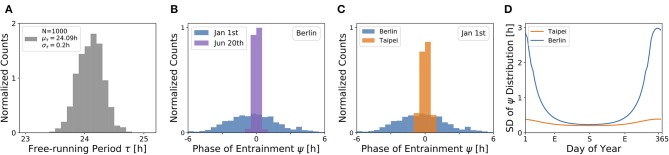
The distribution of chronotypes broadens in winter and at higher latitudes. (A) Distribution of free-running periods τ sampled from a normal distribution of mean μτ = 24.09 h and standard deviation στ = 0.2 h, following what has been described for female human using a forced desynchronization protocol (Duffy et al., 2011). (B) Distribution of entrainment phases ψ (i.e., of chronotypes), that follows from a period distribution as depicted in (A) under natural light entrainment in winter (Jan 1st) and summer (Jun 20th) at the latitude of Berlin (ψ = 52.51°). Approximately 12% of the (most extreme) sampled periods τ do not properly entrain under the conditions on Jan 1st. (C) Distribution of entrainment phases ψ during winter (Jan 1st) in Berlin (blue) and Taipei (orange). (D) Systematic analysis of the standard deviation in the distribution of ψ throughout the year at the latitude in Berlin (blue) and Taipei (orange). In the computations underlying panels (B–D), oscillator parameters others than τ are held constant to A = 6 and λ = 0.1 h−1.